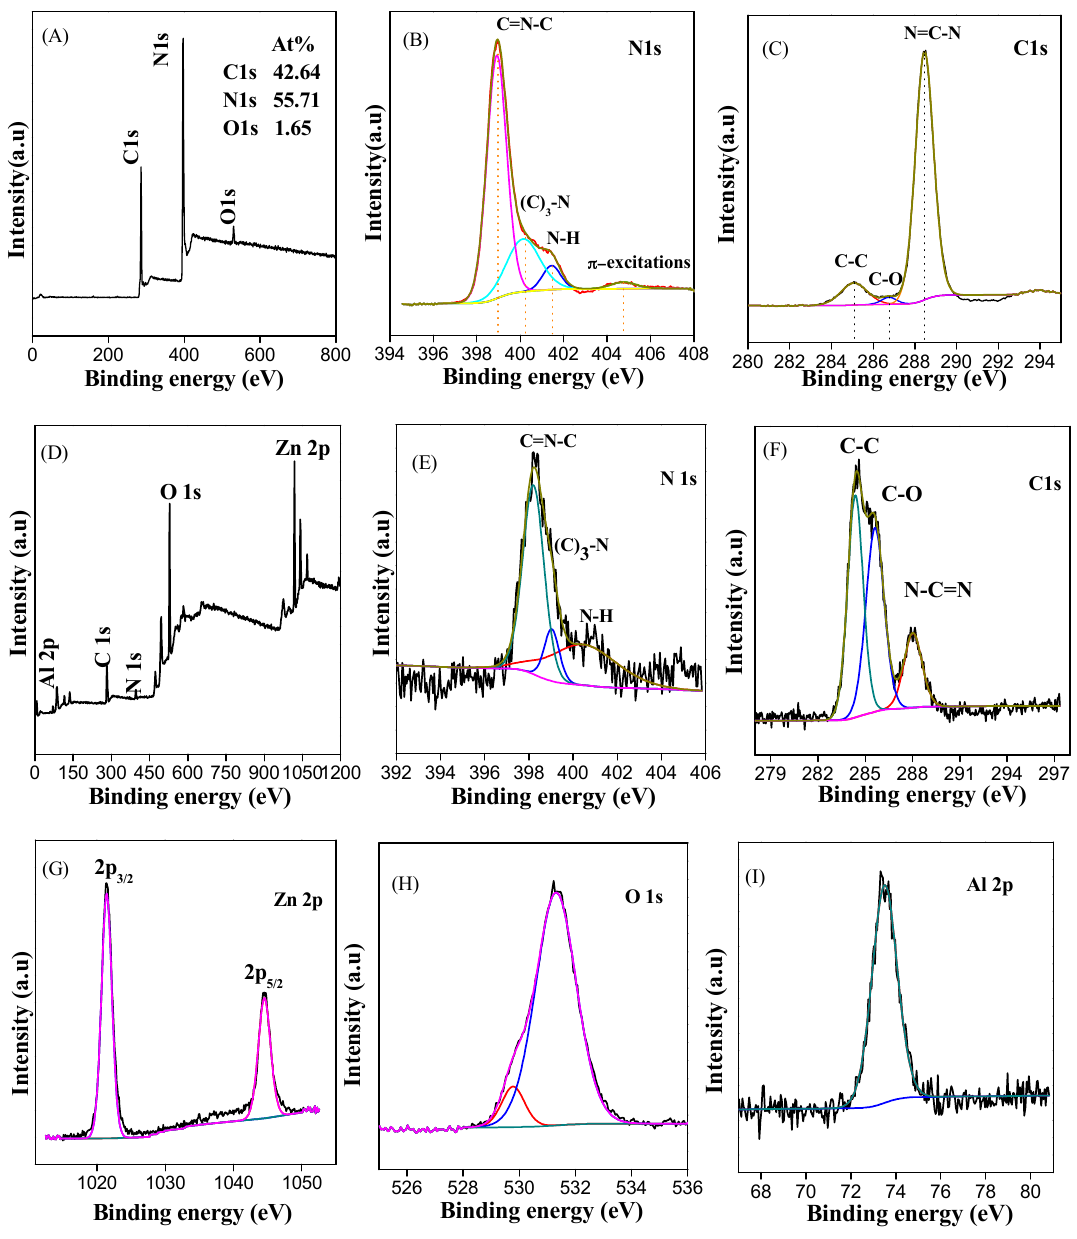
Figure 2. XPS images of the g-C 3 N 4 and ZnO-LDH@C 3 N 4 composite. ( A ) Survey spectrum for g-C 3 N 4 ;